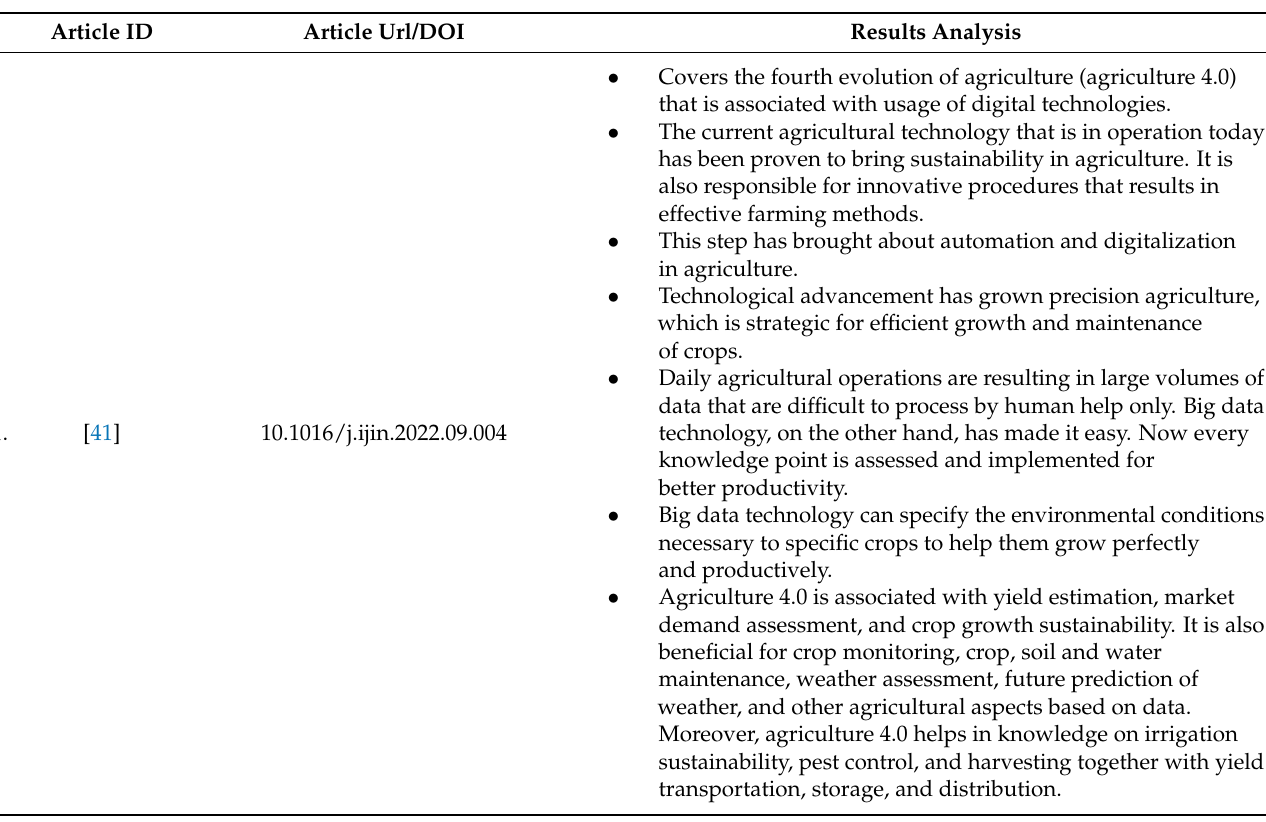
Table 1. A comprehensive description of the main